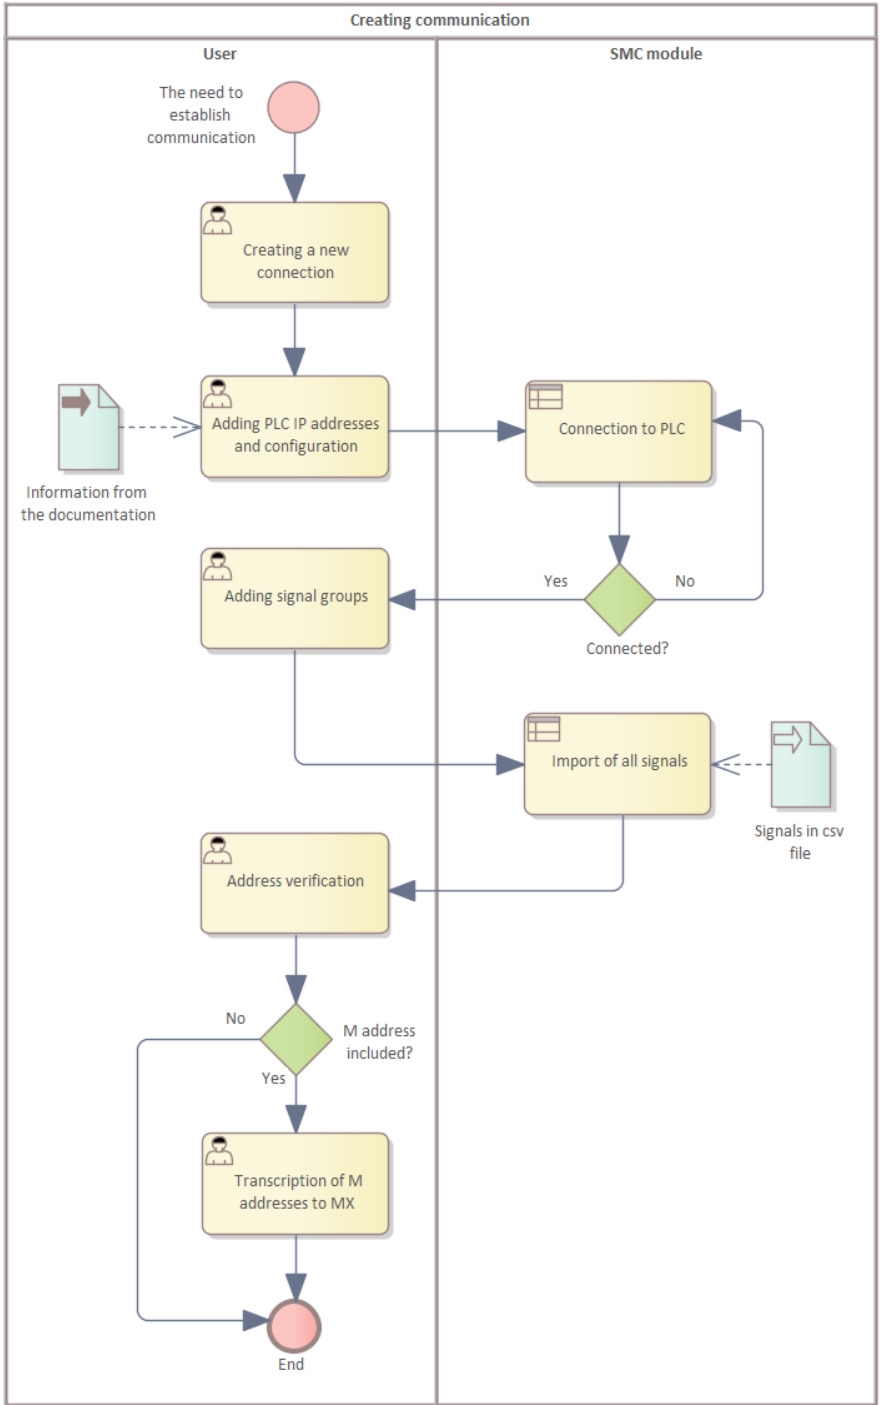
Figure 5. Establishing a connection between the PLC and the SMC.